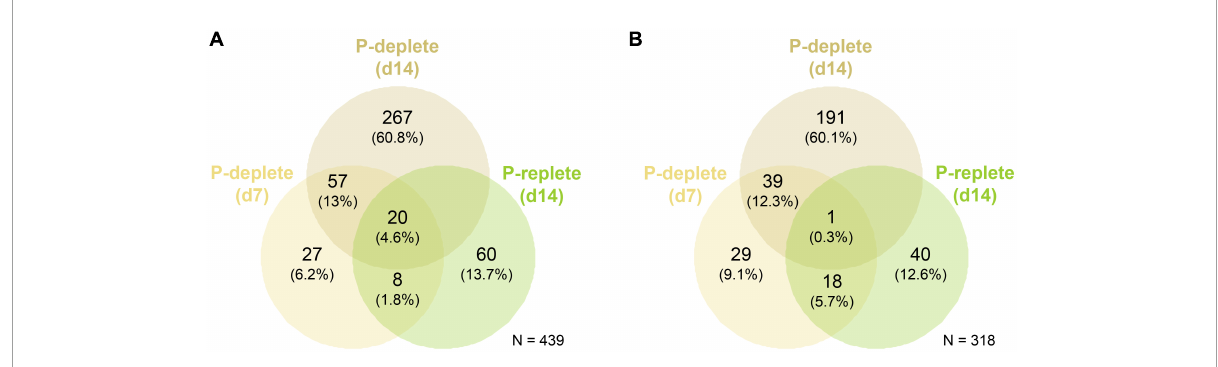
FIGURE2 Venn diagrams for the global quantitative comparison of expression changes in Nodularia spumigena CCY9414 under P-replete (+P) or P-deplete (–P) conditions. Number of up-regulated (A) and down-regulated (B) genes under P starvation in the comparison of P-deplete and P-replete conditions at day 7, P-deplete and P-replete conditions at day 14, and between P-replete conditions at day 14 and day 7, respectively. The RNA-seq experiment was conducted with samples from the second experiment